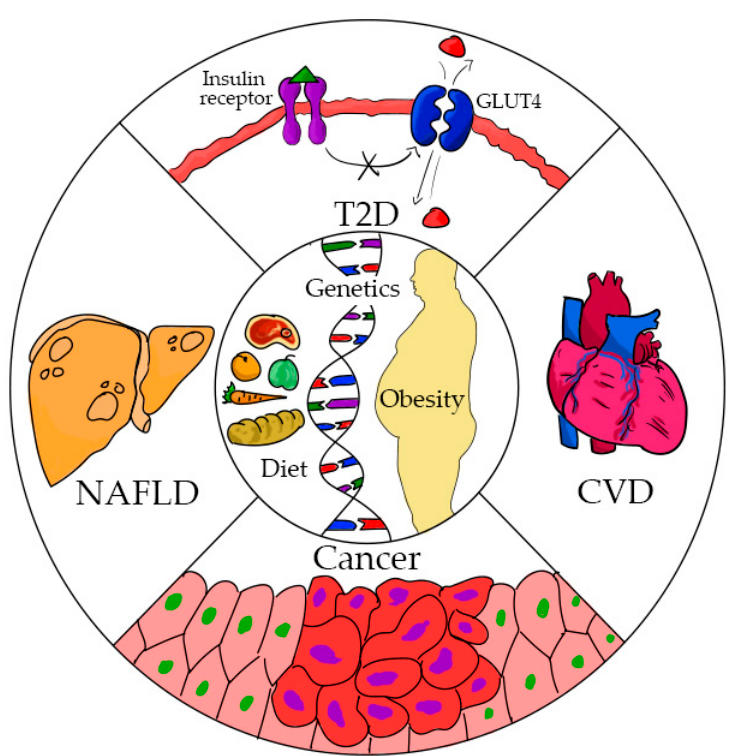
Figure 1. This figure depicts the main components associated with chronic disease in Latinos, gene variants, obesity, and diet (center of the figure) and the most common health disparities in the Hispanic population: non-alcoholic fatty liver disease (NAFLD), type 2 diabetes (T2D), cardiovascular diseases (CVD), and cancer.